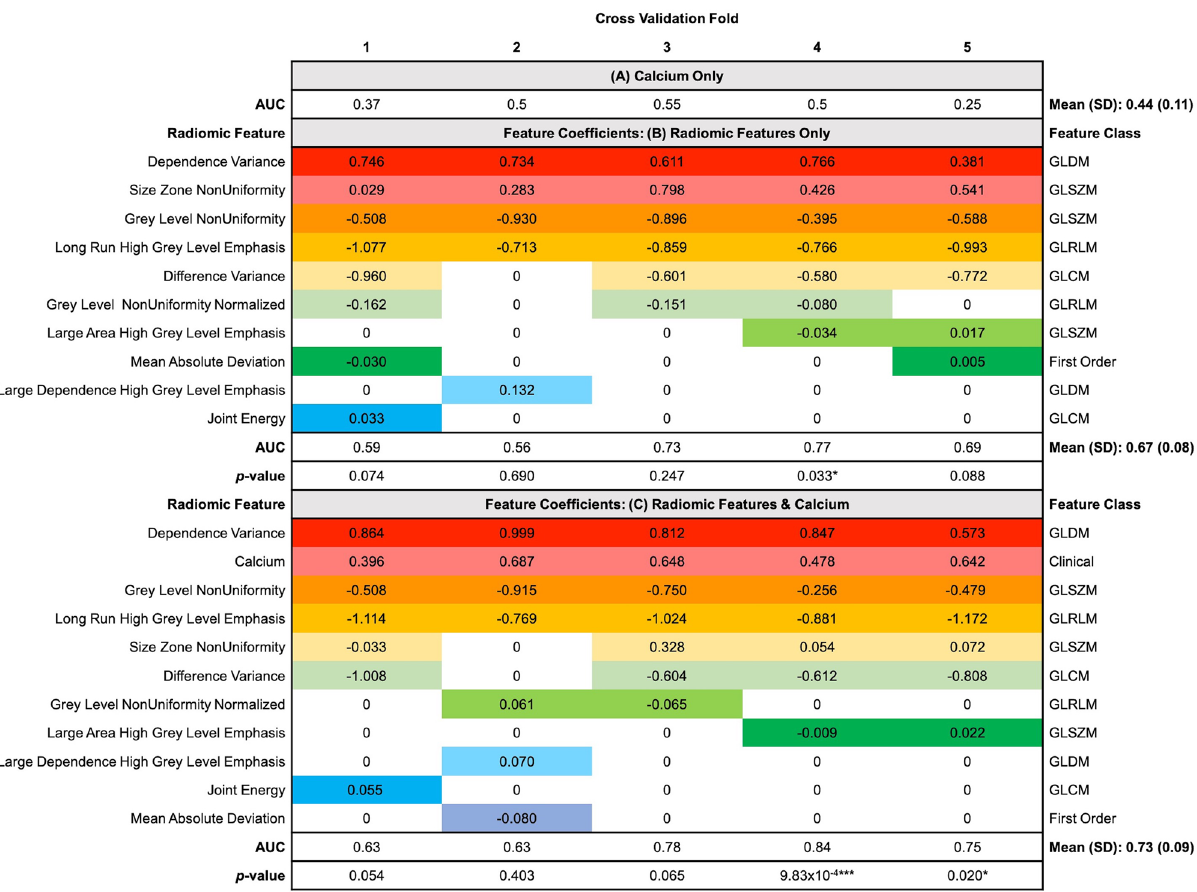
Using radiomic features (with resegmentation to [0, 200 HU]) alone as predictors performed better than carotid calcium alone, with a mean (SD) AUC of 0.67 (0.08) and a p -value of 0.043. The combination of radiomic features with carotid calcium as predictors led to the highest predictive performance, with a mean (SD) AUC of 0.73 (0.09), a mean (95% CI) accuracy of 69% (47–88%) and a p -value of 0.043 when compared with carotid calcium alone and a p -value of 0.042 when compared with radiomic features alone. The performance (mean AUC with SD) of the other machine learning classifiers using radiomic features and carotid calcium as predictors were: decision tree 0.58 (0.19), random forest 0.67 (0.08), LASSO 0.72 (0.09), neural network 0.60 (0.09) and XGBoost 0.56 (0.09). Please see Supplementary Table S6 for the sensitivity and specificity of each individual model. The radiomic feature set (n = 10) for multi-slice analysis with resegmentation is shown in Fig. 4 along with the coefficients for each feature as determined by the Elastic Net classifier per fold within the cross-validation scheme. The feature coefficients indicate the importance of the features for the model’s predictions. Larger positive coefficient values suggest higher importance for predicting the culprit carotid artery class, whilst larger negative coefficient values suggest higher importance for predicting the non-culprit carotid artery class. Overall, there were 3 radiomic features that were highly consistent in being relevant predictors for carotid artery status across every cross-validation fold: (1) GLDM: Dependence Variance, (2) GLSZM: Grey Level NonU- niformity and (3) GLRLM: Long Run High Grey Level Emphasis.